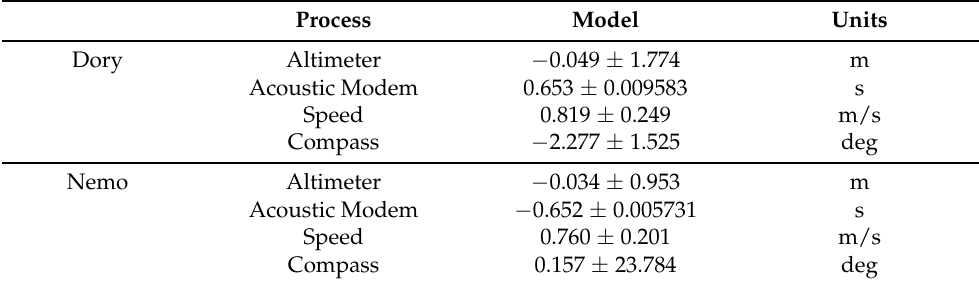
Table 2. Empirical Riptide